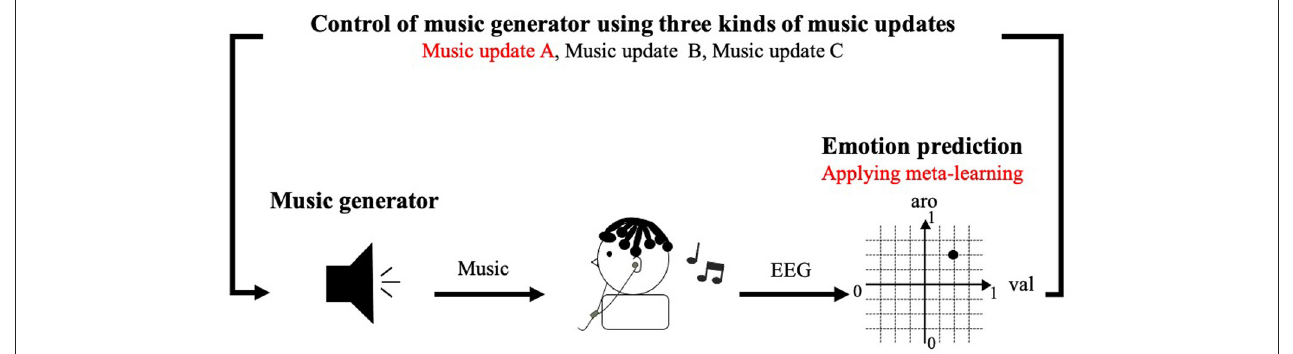
FIGURE 5 | Emotion induction system using meta-learning: Red text is newly implemented methods in this